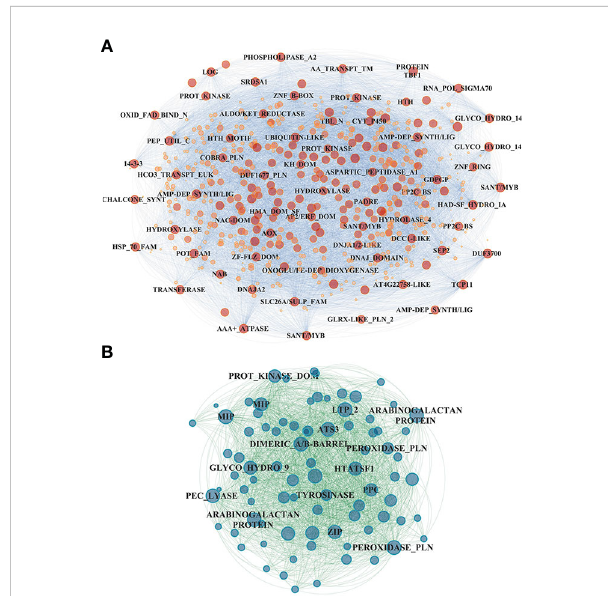
FIGURE 5 Network visualization of the midnight blue module detected in the shoot (A) and the gray60 module detected in the roots (B) . Hub gene annotation (SL3.2) is highlighted on each